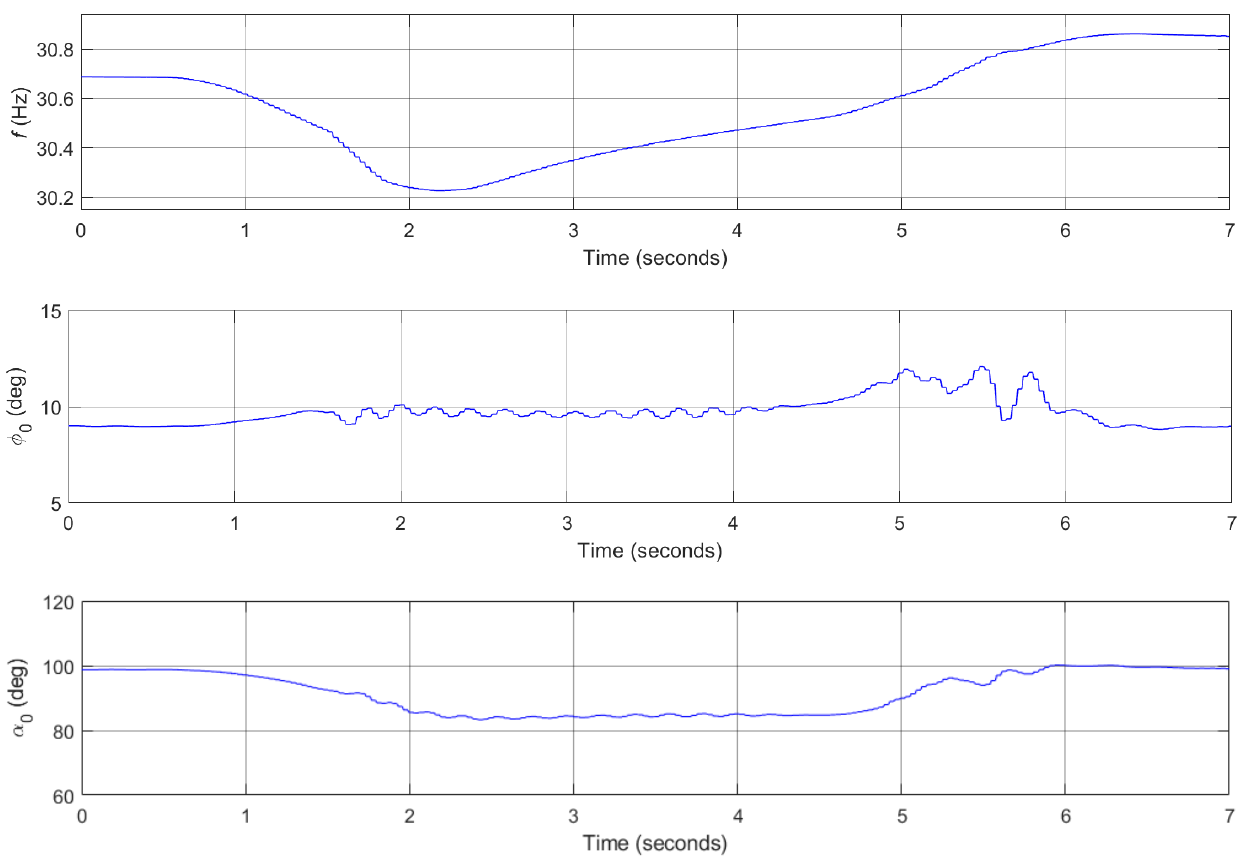
Figure 22. Flight control inputs for transition flight control of nonlinear FWMAV model.